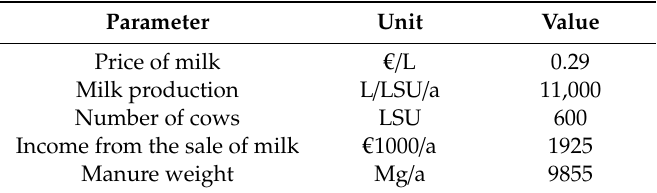
Table 1. Characterization of the analyzed dairy farm.